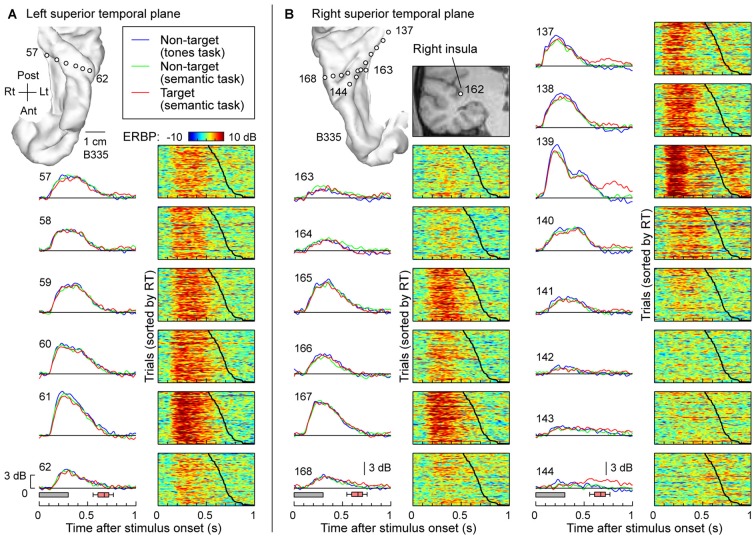
High gamma responses to words “cat”, “dog”, “five” and “ten” recorded from the Heschl’s gyrus (HG) in subject B335. (A) Responses recorded from a depth electrode that targeted the left HG (contacts 57–62). Magnetic resonance imaging (MRI) reconstruction of the top-down view of left superior temporal plane depicting the location of the recording sites is shown in the top left corner. Left column: high gamma event-related band power (ERBP) waveforms, averaged across trials where the stimuli were non-targets in a tone detection task, non-targets in a semantic categorization task and targets in a semantic categorization tasks (plotted in blue, green and red, respectively). Gray boxes underneath high gamma waveforms represent stimulus duration (300 ms); pink box-and-whiskers plots denote the timing of button presses to the target stimuli (median, 10th, 25th, 75th and 90th percentile; same convention used for subsequent figures). Right column: waterfall plots showing single-trial high gamma ERBP in response to the target stimuli. Trials are sorted by RT (top to bottom: shortest to longest). Thick black line indicates RTs for each trial. (B) Responses recorded from two depth electrodes that targeted the right insula (contact 162) traversing planum temporale (contacts 163–168) and right HG (contacts 137–144). MRI reconstruction of the top-down view of right superior temporal plane showing the location of the recording sites is shown on the top left. Inset: MRI coronal section through the right temporal cortex showing location of contact 162 that targeted the insula. Average high gamma ERBP waveforms and single-trial high gamma waterfall plots are depicted for each site in the superior temporal plane as in (A). Note that a click was associated with the button press and was likely responsible for target-specific activity seen on contacts within core auditory cortex (e.g., contact 139).